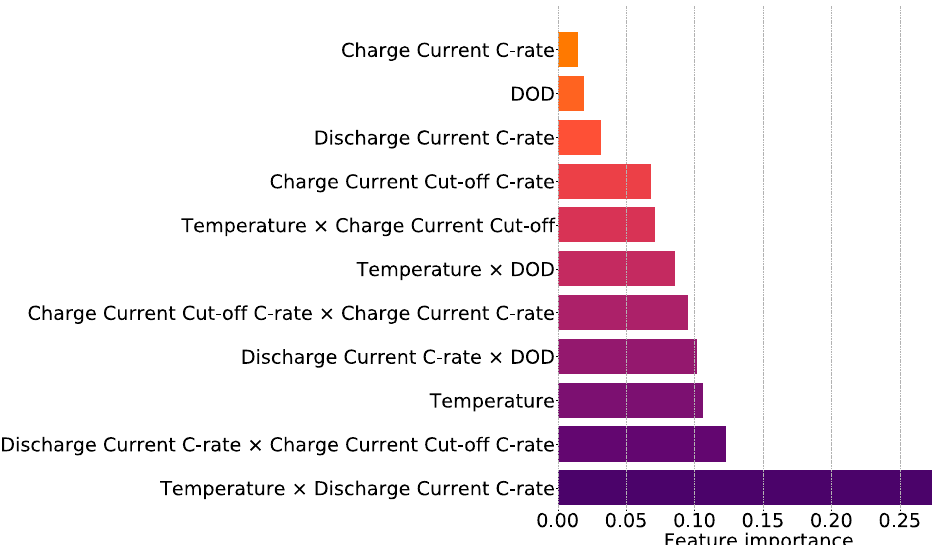
Figure 10. RF results for predictor variable (feature) ranking in decreasing order of importance for Manufacturer 2.